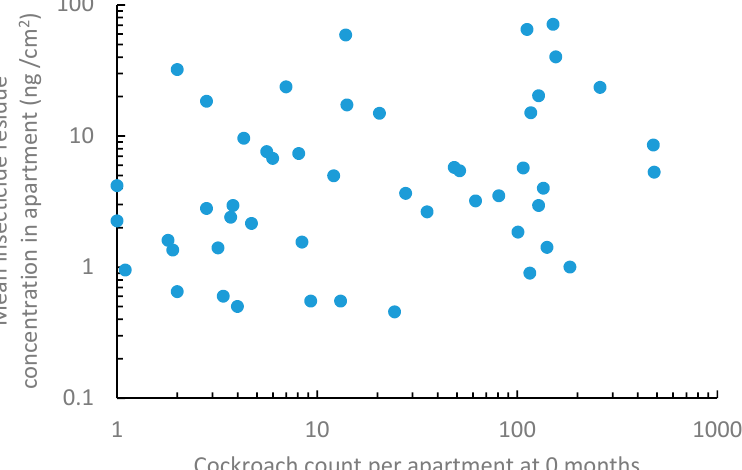
Figure 1. Association between insecticide residue concentration per apartment (mean residue concentration measured in bedroom and kitchen) and initial cockroach count. For regression analysis, those apartments without detected residue and those with a cockroach count <10 were excluded because there are many apartments with small counts, which cause the data to be not normal even after logarithmic transformation.